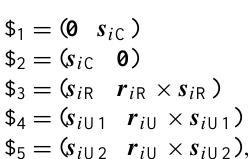
Figure 6. Twist systems of a CRU limb. Fig.